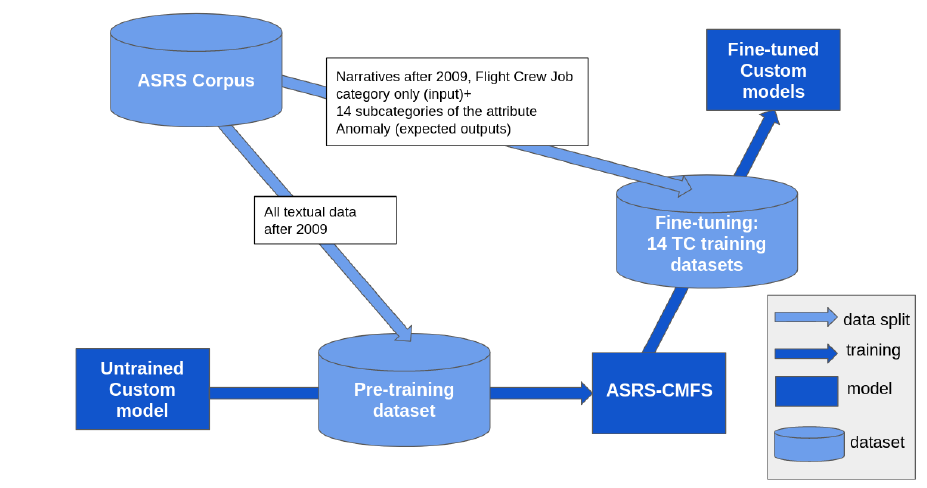
Figure 5. NLP pipeline.